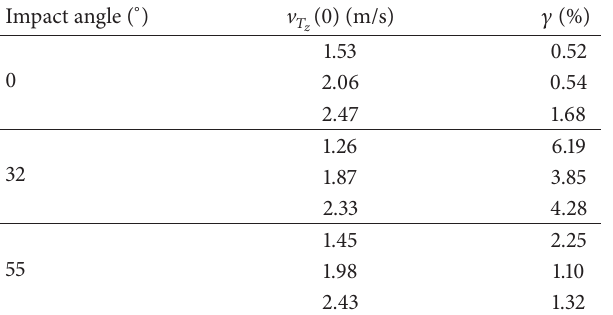
Table2:Relativeerrorbetweentheexperimentalandthesimulation results of the free